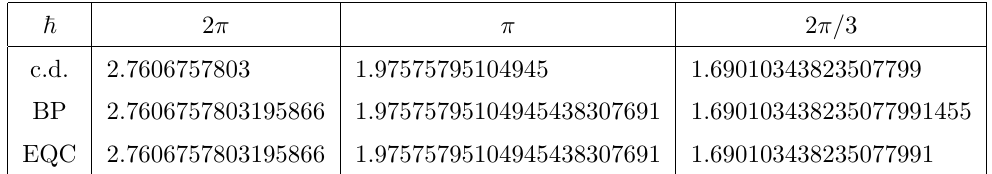
= (cid:25) i and three di(cid:11)erent values 0